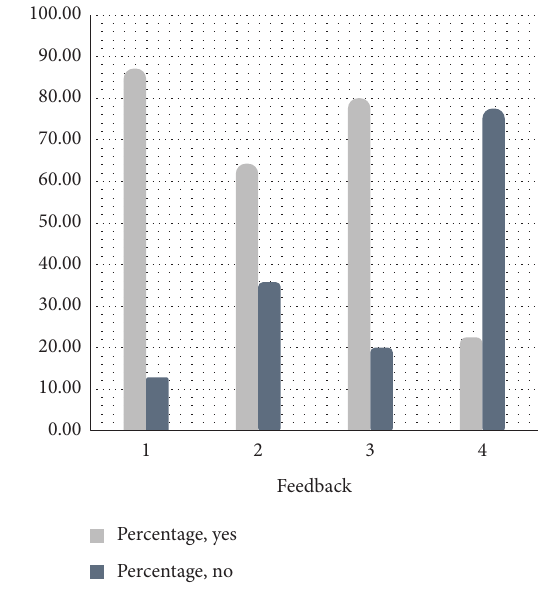
Figure 6: Customer feedback.